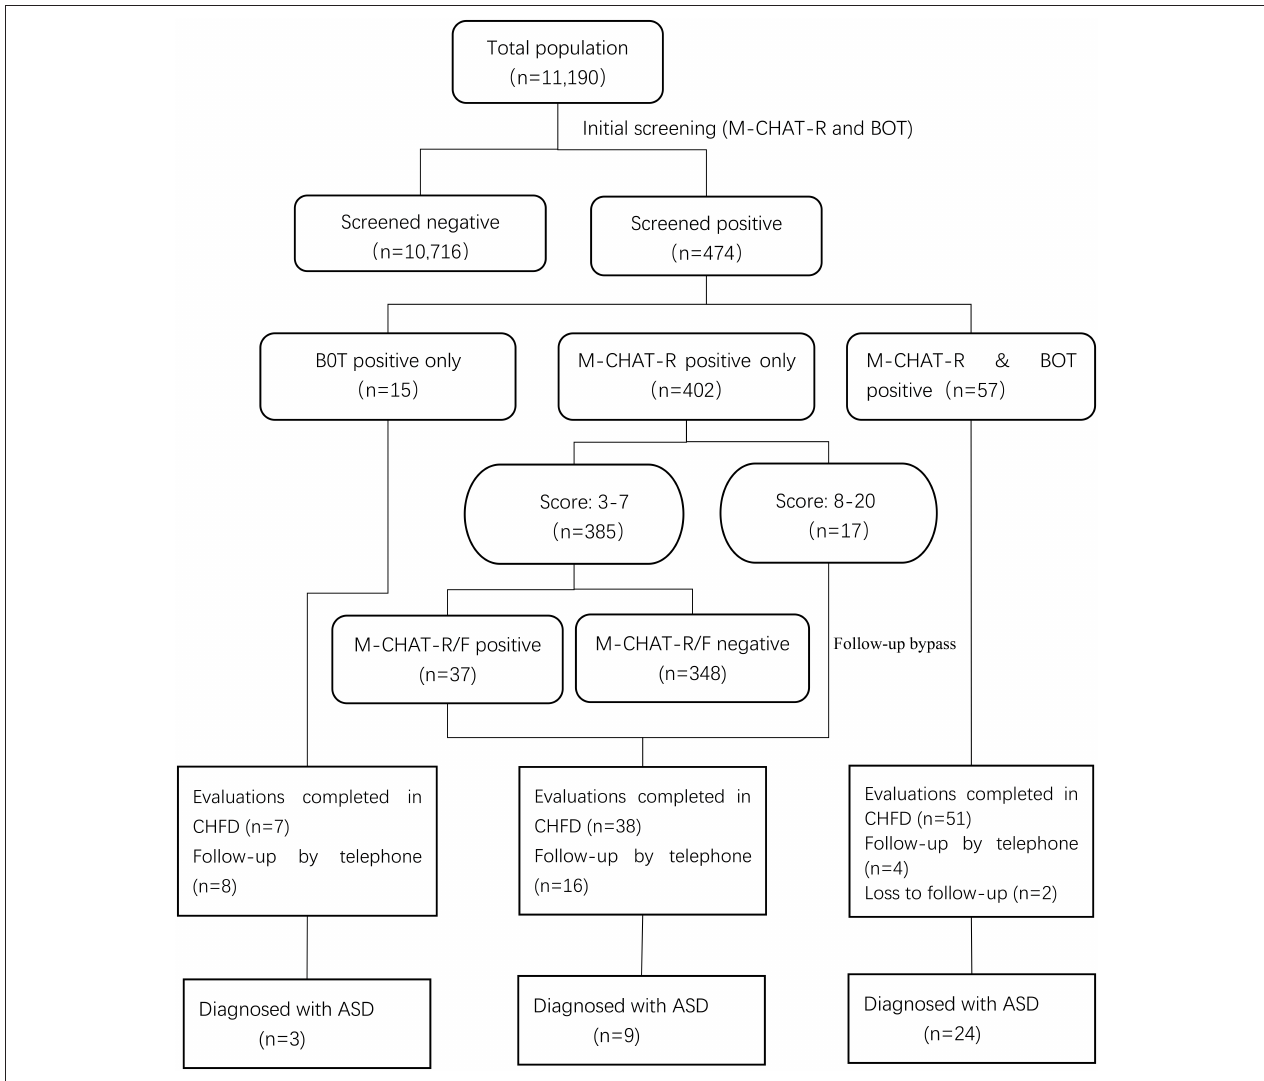
FIGURE 3 | Flowchart displaying the screening and diagnosis results for all toddlers studied.